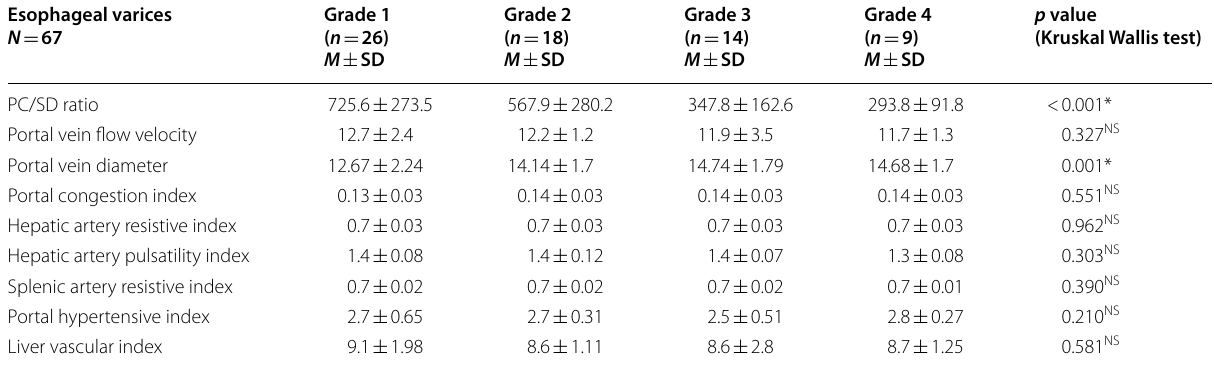
NS no significant difference, P > 0.05 =